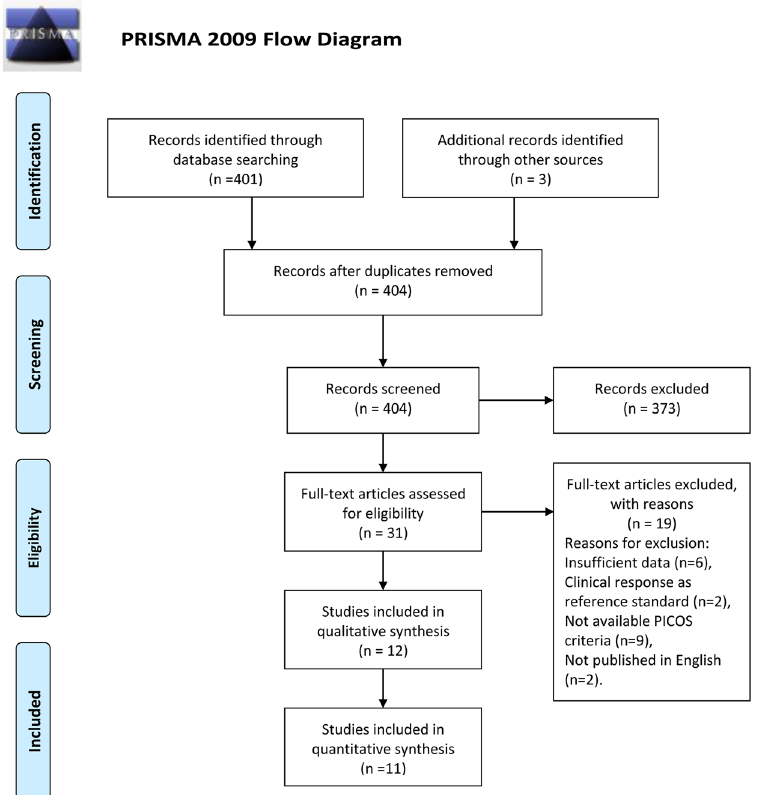
Figure 1. Flowchart illustrating the selection of studies 32